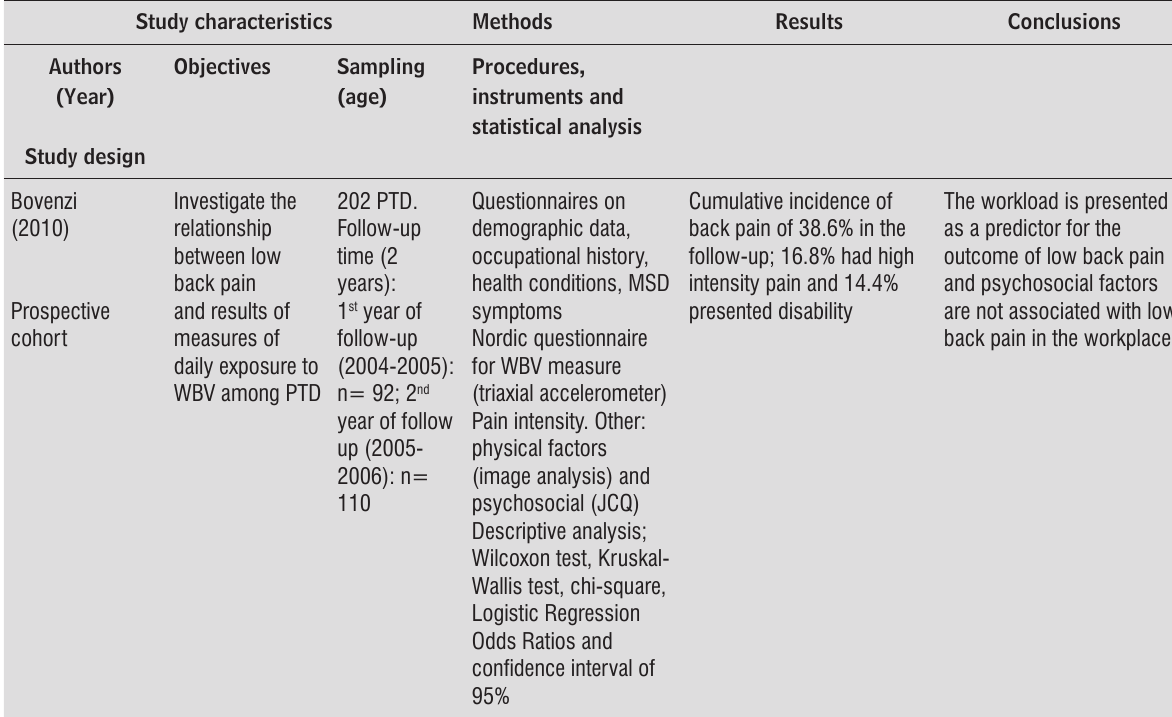
Table 3 - Characteristics of the articles selected for systematic